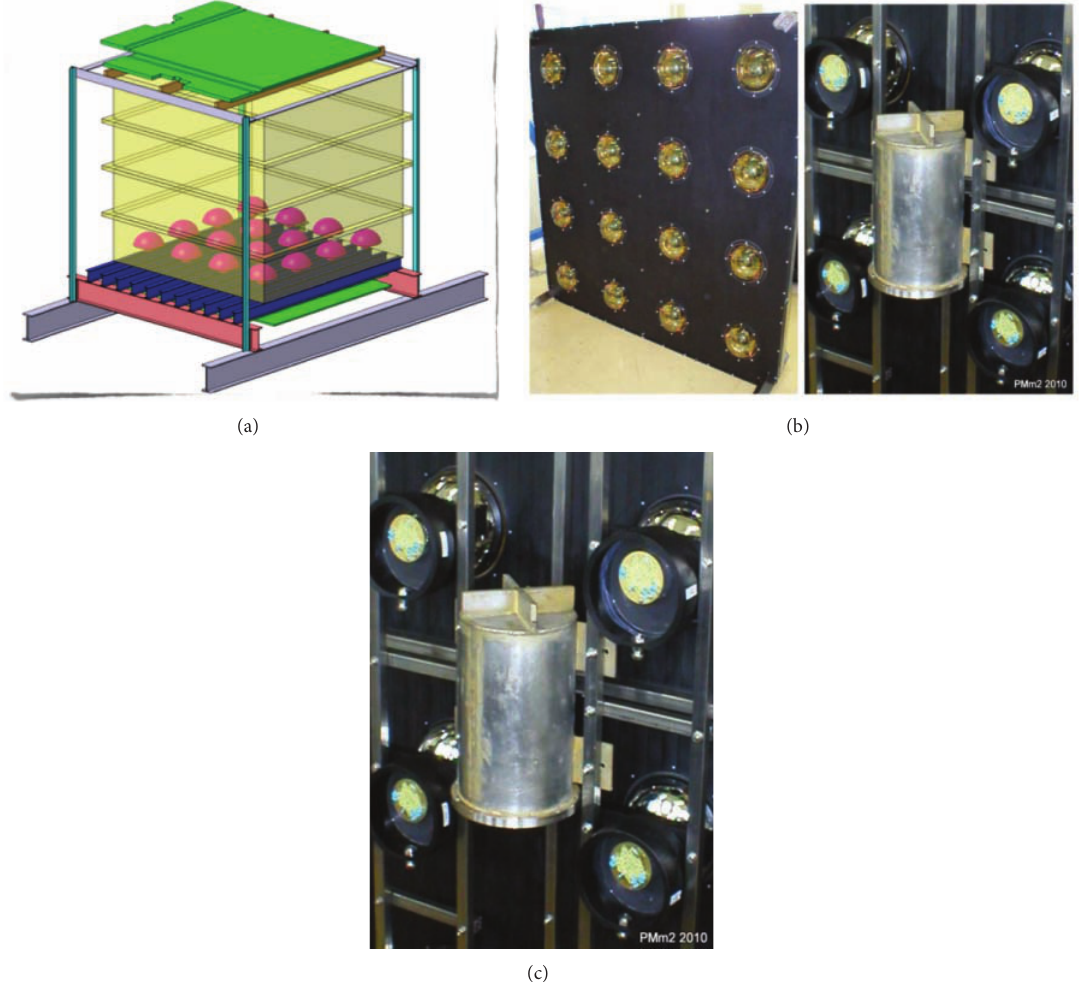
Figure 31: (a) Schematic view of the MEMPHYNO prototype. (b) Photograph of the PMm2 matrix of 16 8 󸀠󸀠 Hamamatsu PMTs. (c) Backside of the matrix showing the watertight box for the